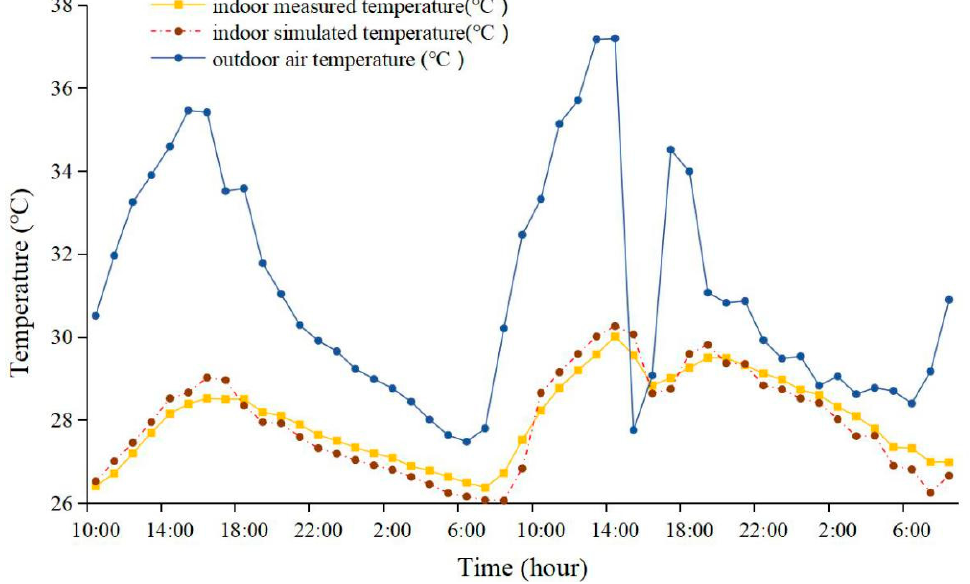
Figure 3. Field experiment data. The red line and the yellow line had a similar trend. The Pearson coefficient of the measured data and the simulated data was 0.969 [49]. This field experiment improved confidence in the accuracy of the ENVI-met model in this study.